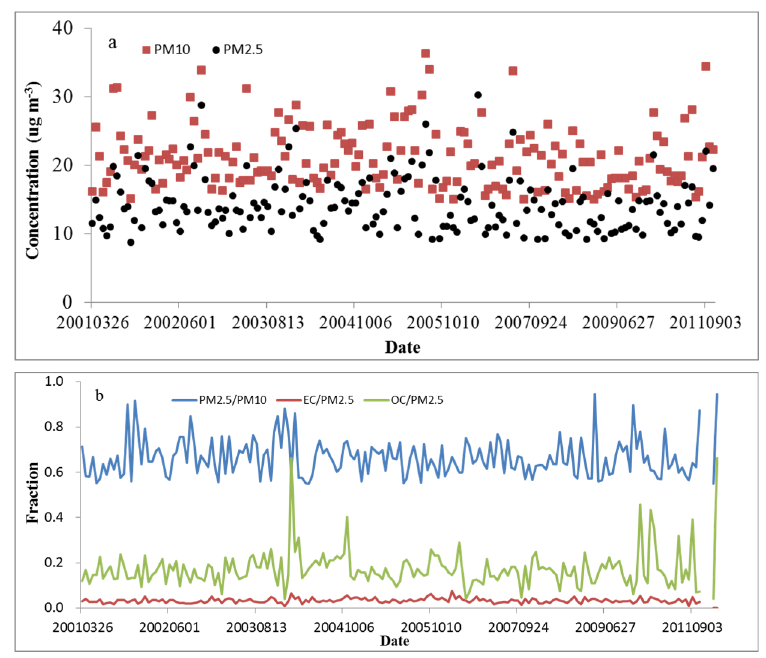
Figure 6. Characteristics of aerosols. ( a ) Concentrations of PM 2.5 and PM 10 . ( b ) Fractions of PM 2.5 /PM 10 , EC/PM 2.5 , OC/PM 2.5 ) during fire events at the WIMO1 site between 2001 and 2011.